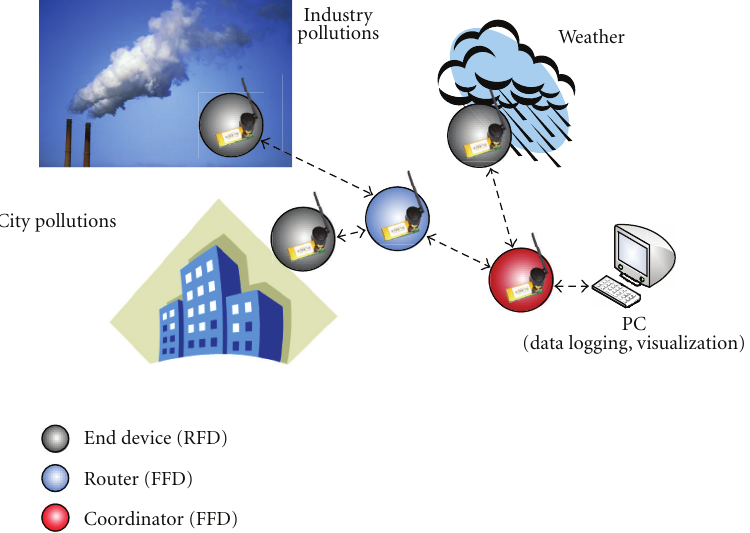
Figure 13: Visualization of measurement chain using developed wireless